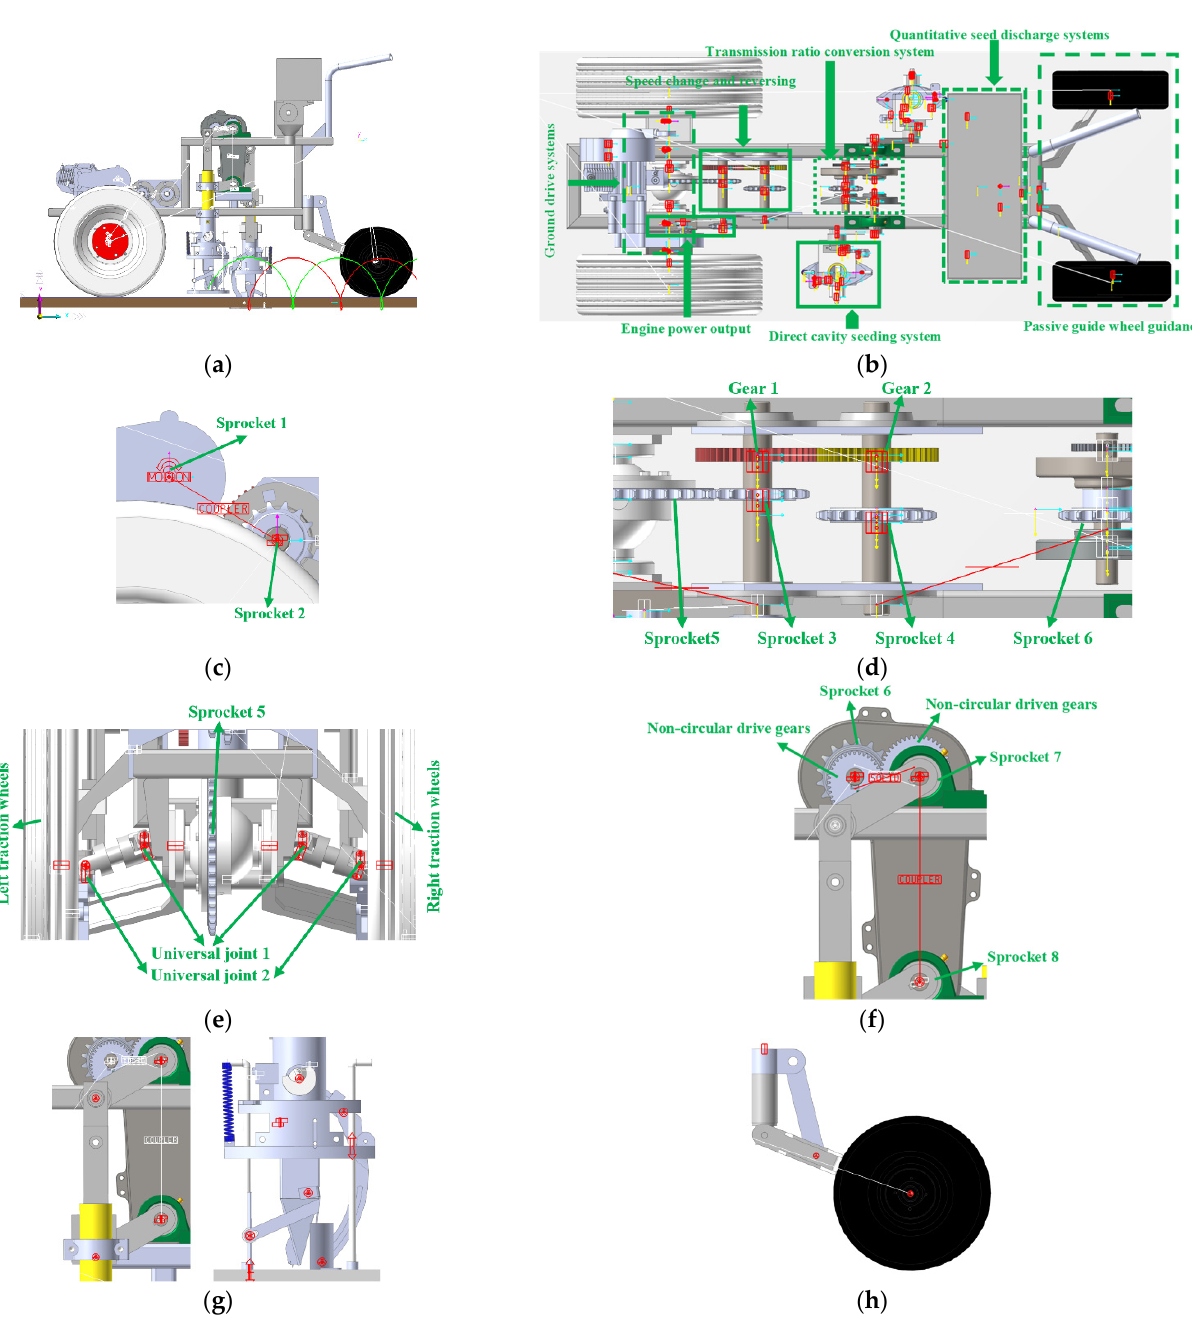
Figure 2. Constraint relationships of the cavity planter with vertical insertion. ( a ) Virtual prototype model. ( b ) Drive train division. ( c ) Engine power output. ( d ) Speed changing and reversing. ( e ) Ground drive system. ( f ) Transmission ratio conversion system. ( g ) Cavity seeding system. ( h ) Passive wheel guidance.